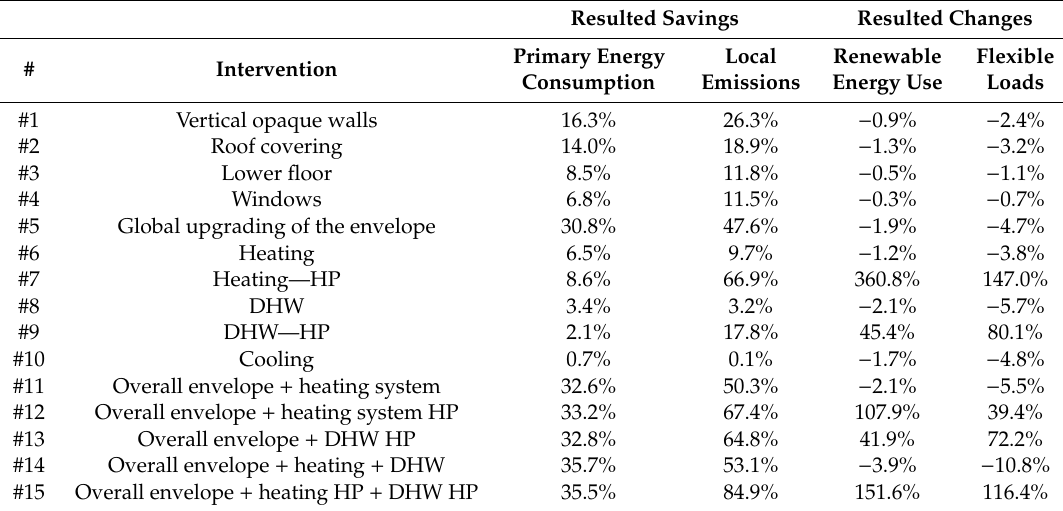
Table 6. Summary of interventions and related changes. Resulted Savings Resulted